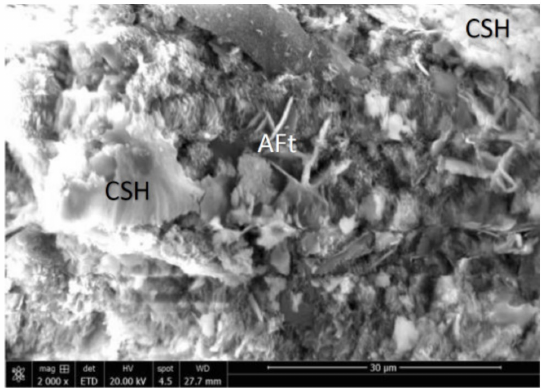
Figure 7. Typical SEM of Ni-Fe Slag Powder Soil Cement ( ×